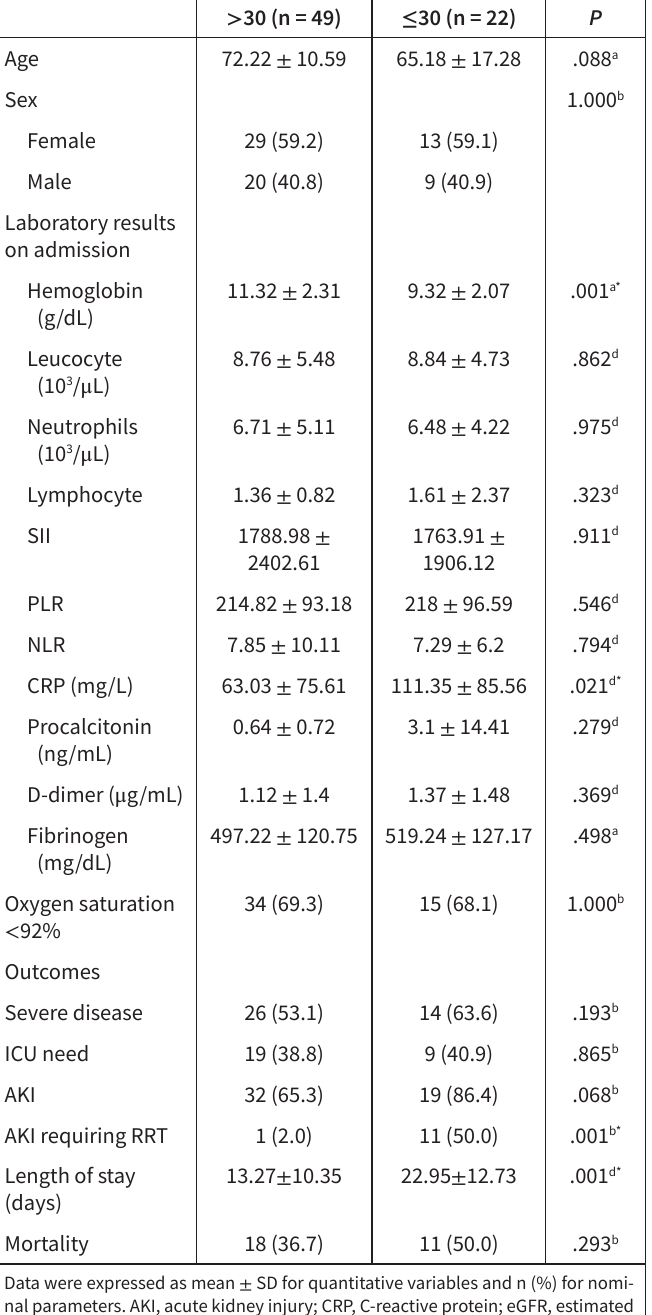
Table 4. Comparison of the Patient Characteristics According to the Cut-off Level of SII